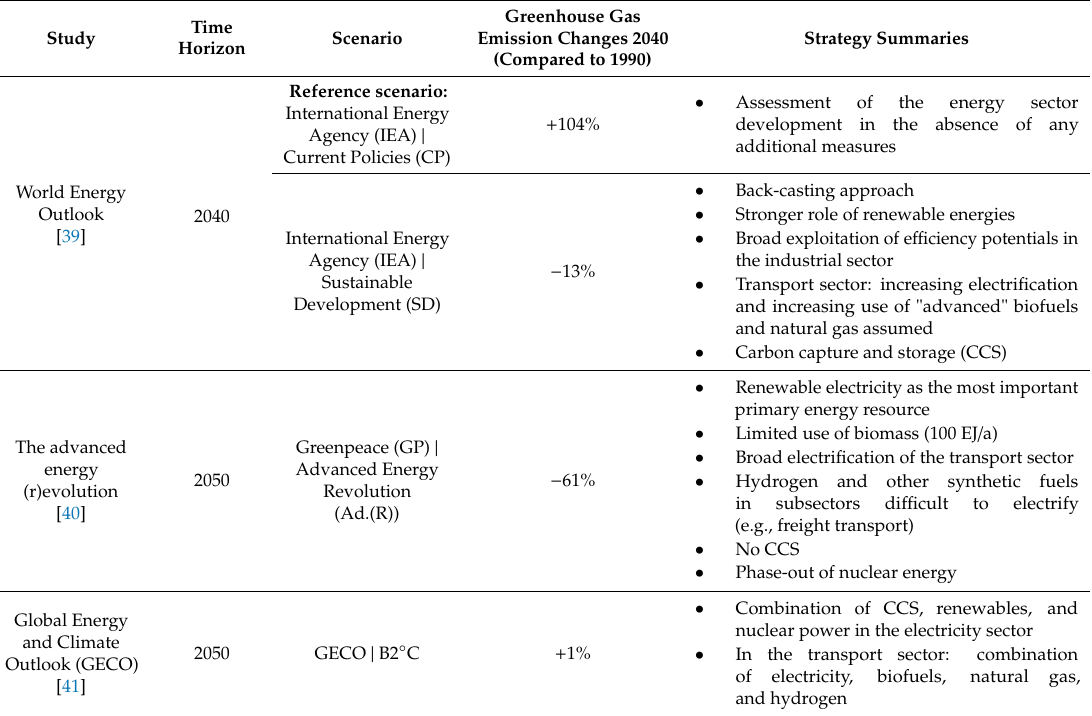
Table 1. Overview of selected energy